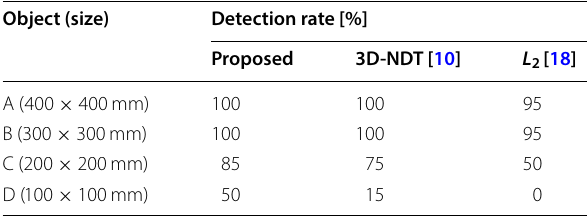
Table 3 The detection rate for four kinds of objects Object